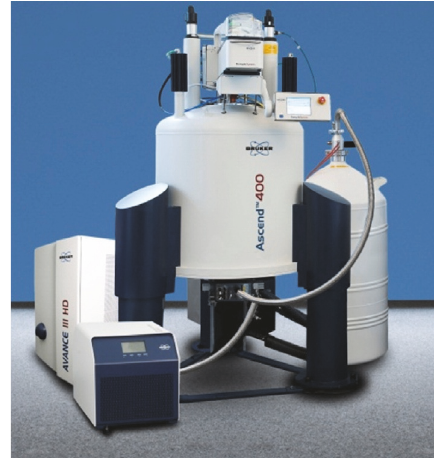
Figure 4: Bruker BioSpin NMR Spectroscopy.